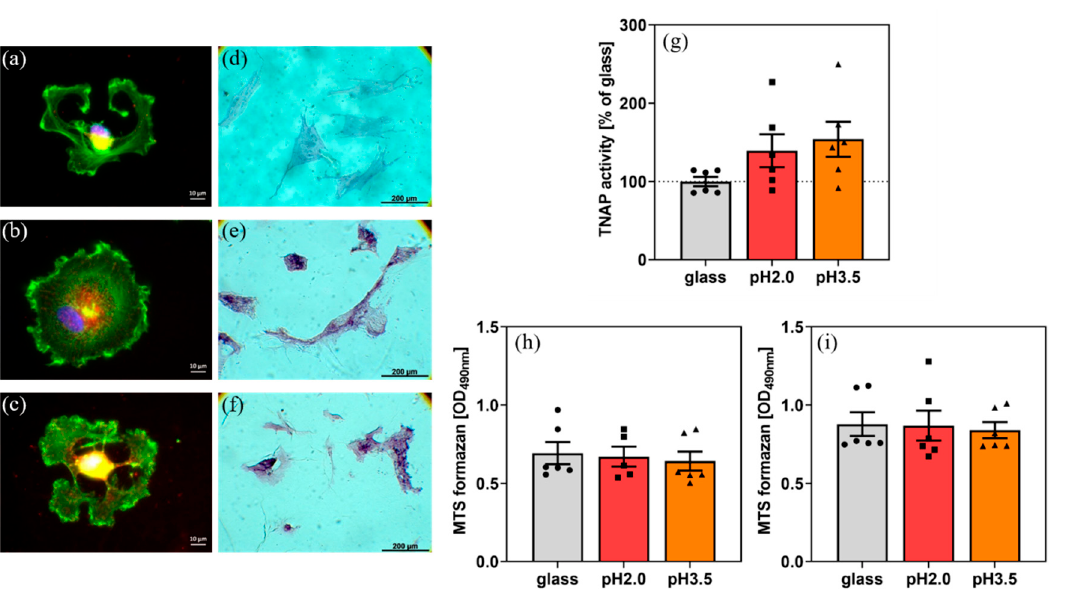
Figure 2. ( a ) Contact angle (CA) measurements of uncoated and fibrillar coated samples with solution at pH 2 and pH 3.5 and SEM images of fibrillar coatings obtained at ( b ) pH 2 and ( c ) pH 3.5 (scale bar: 1 μ m).